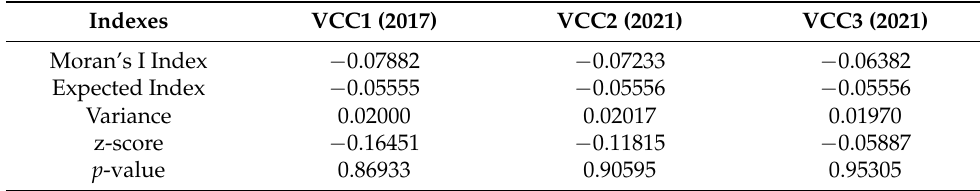
Table 3. Global Moran’s I for VCC.